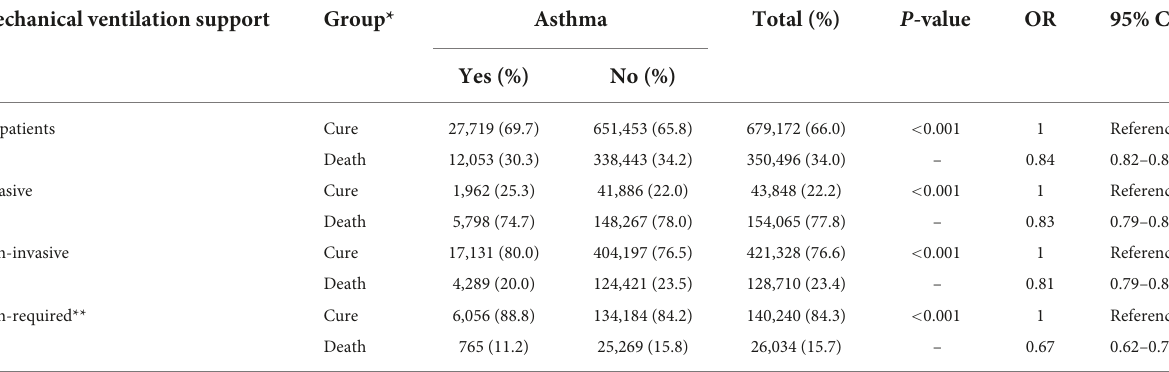
TABLE 3 Association between outcome and the asthma diagnosis in hospitalized patients with severe acute respiratory syndrome (SARS) due to coronavirus disease (COVID-19) in Brazil, according to the mechanical ventilation support. Mechanical ventilation